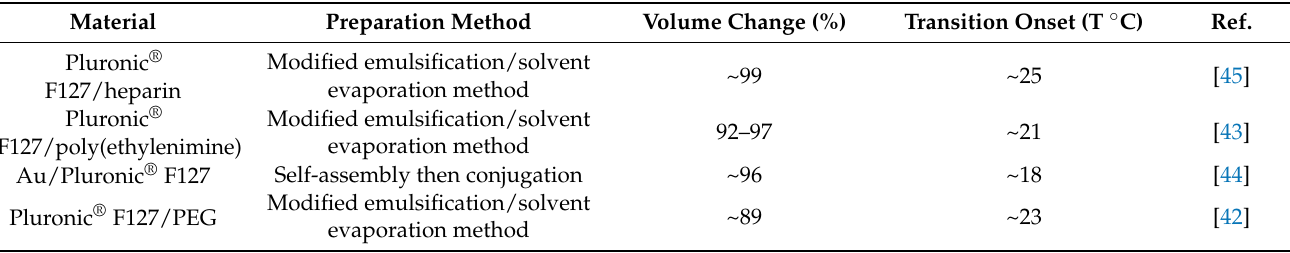
Figure 4. Chemical structures of monomers commonly used in the synthesis of PNIPAAm copolymers with modulated thermoresponsive properties, classified based on their charge. Table 1. Volume change % and transition temperatures (in D 2 O or PBS) of some thermo-responsive Pluronic F127-based particles.